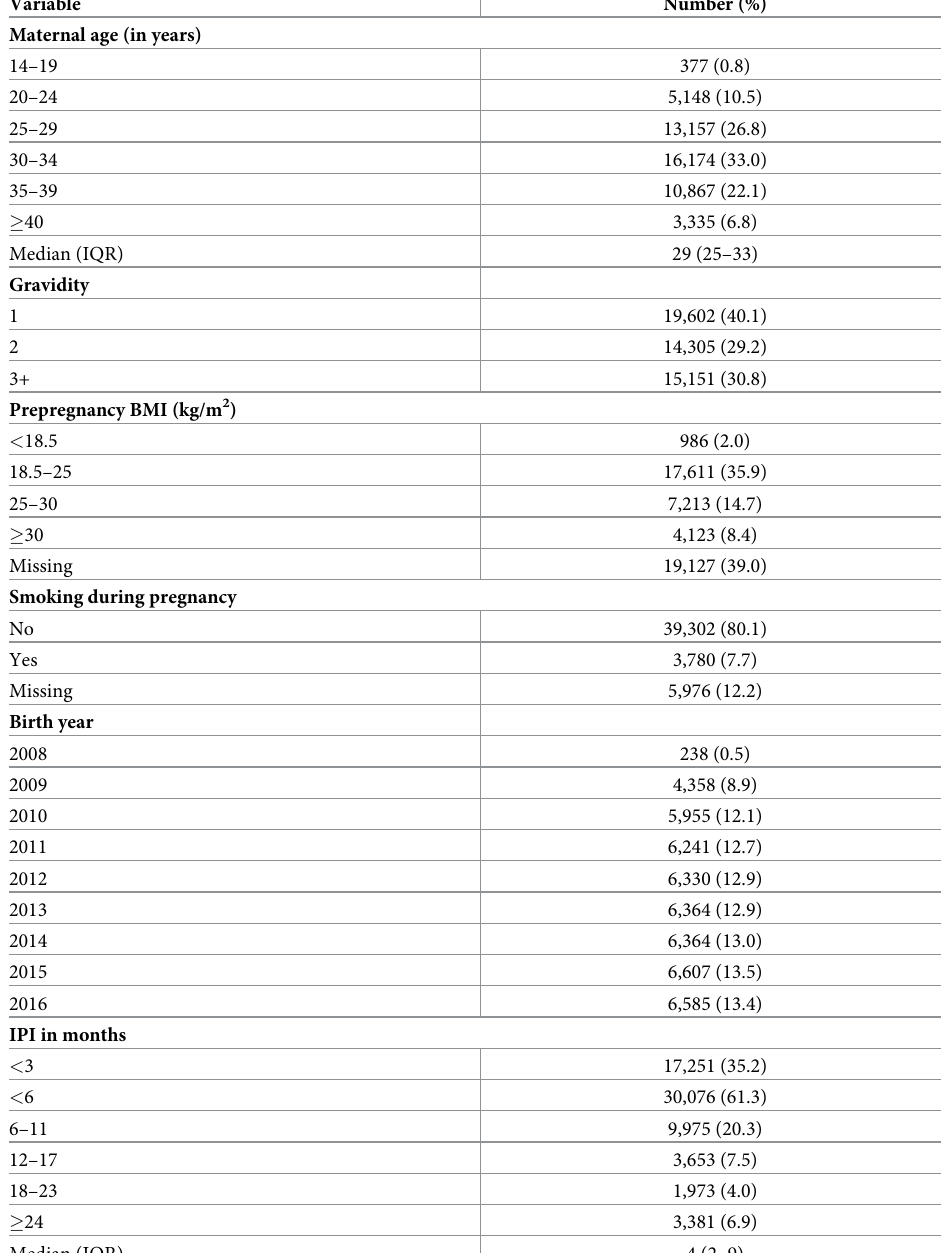
Table 1. Characteristics for women with births after miscarriage and induced abortion at the time of birth after the IPI for births between 2008 and 2016 in Norway ( n = 49,058).